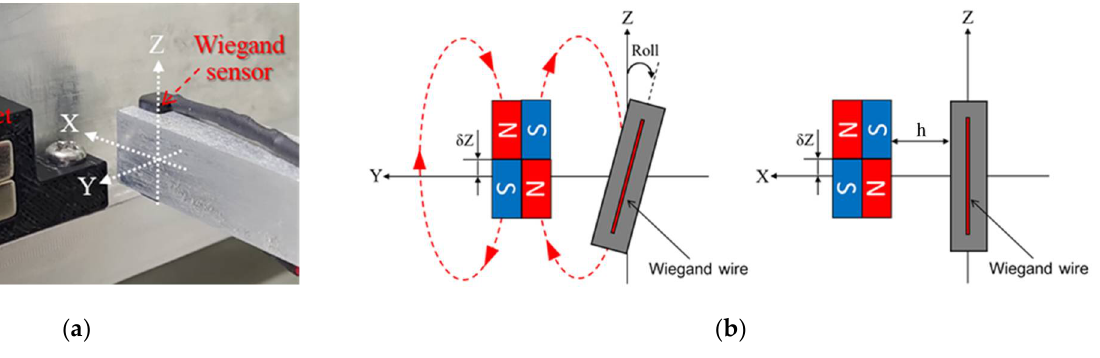
Figure 8. Configuration of Wiegand sensor and magnets: ( a ) isometric view ( b ) front view and side